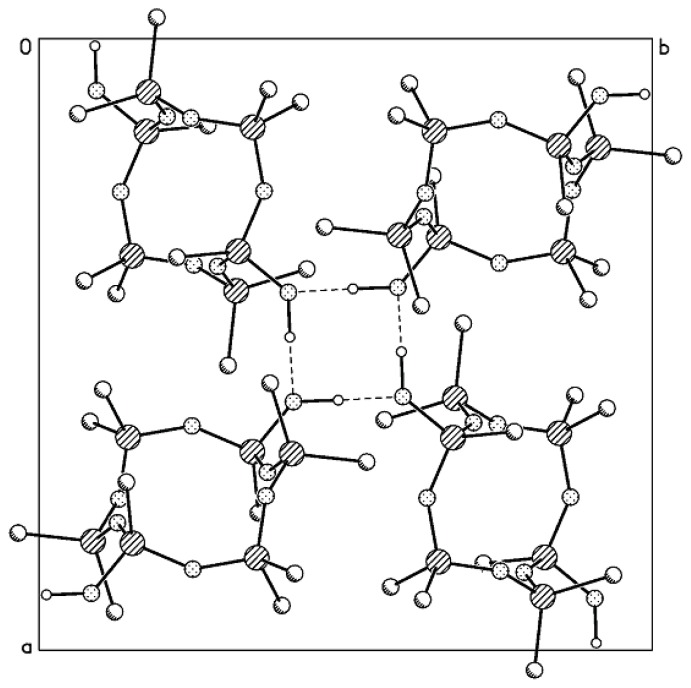
Molecular packing in the crystal of Compound MVII-OH (projection on the ab plane). Dashed lines denote intermolecular H-bonds that link molecules to form tetramers.